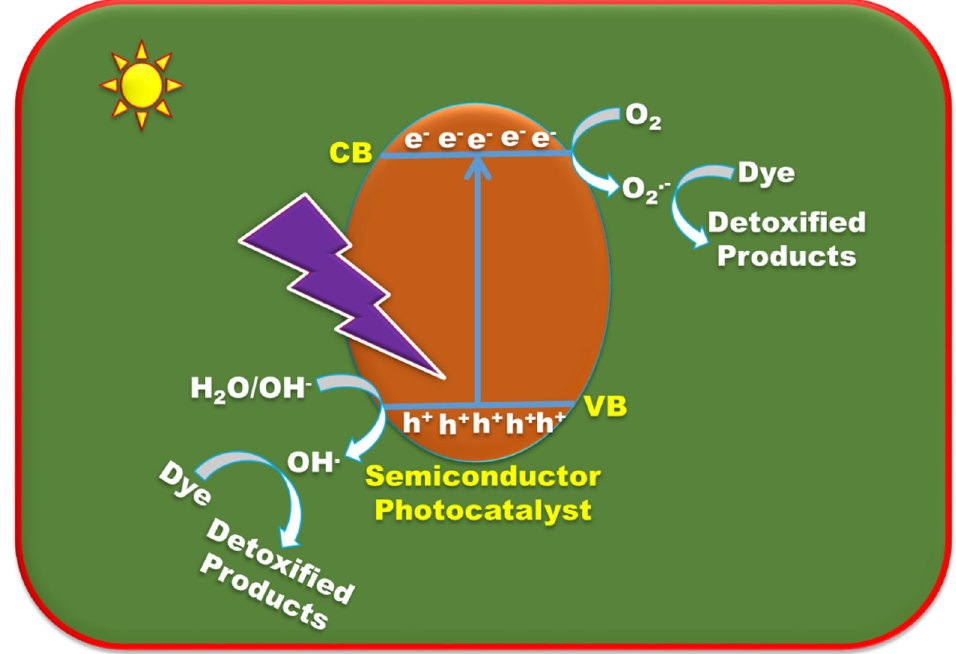
Scheme 1. Fundamental mechanism of photocatalytic-dye detoxification over a semiconductor